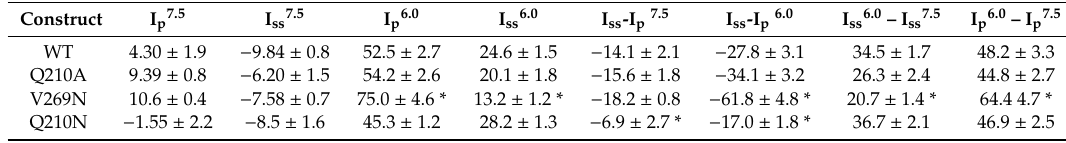
Table 2. Summary of reversal potentials. The superscript denoted the pH of the solution used. Values are reported at the average ± SEM (n = 7–15). Statistically significant values are denoted with * ( p < 0.05).